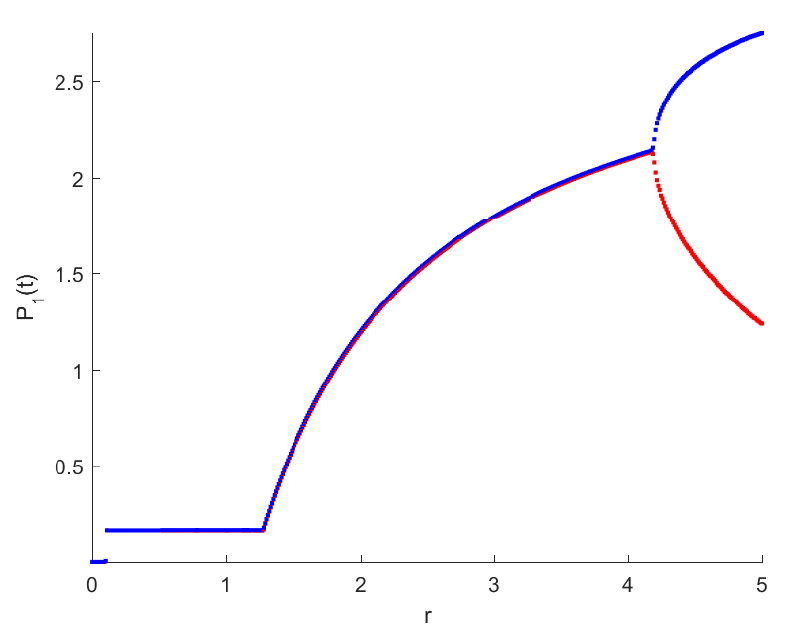
Figure 4. Bifurcation diagram of RPW system (1) with respect to r .